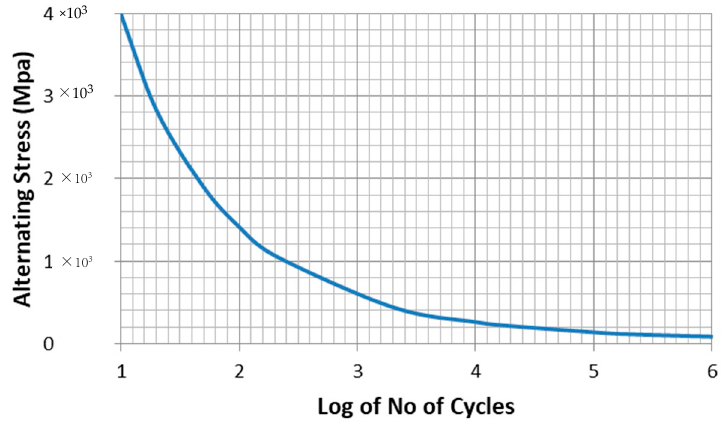
Figure 10. S–N curve of steel.